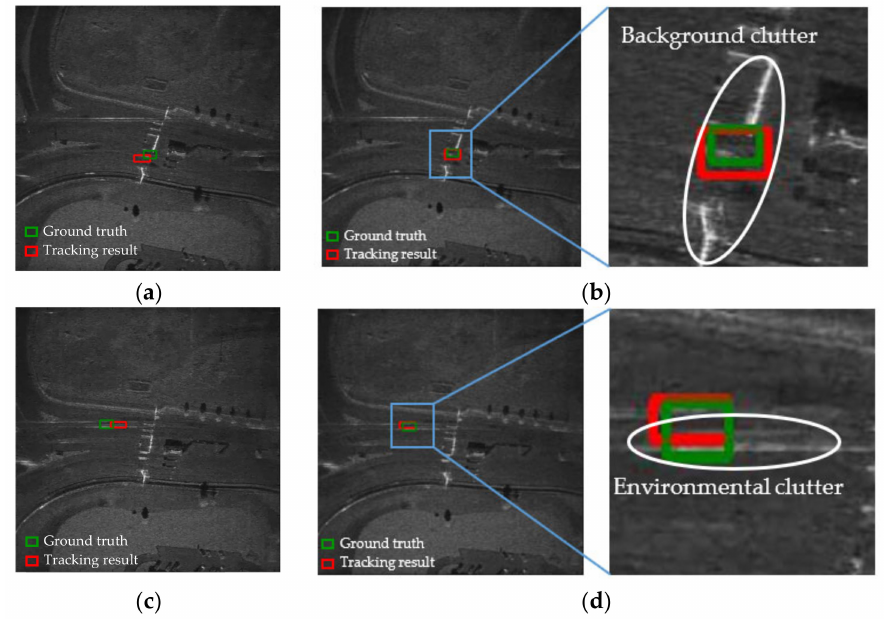
Figure 22. Tracking results with interference: ( a ) Siamese-RPN with background clutter; ( b ) our method with background clutter; ( c ) Siamese-RPN with environmental clutter; ( d ) our method with environmental